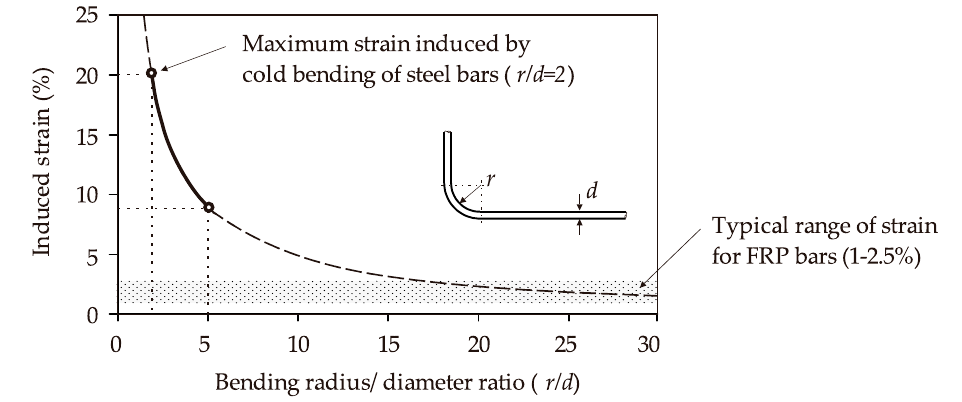
Figure 1. Induced strain values in cold-bent bars (adapted from Imjai et al. [38]).